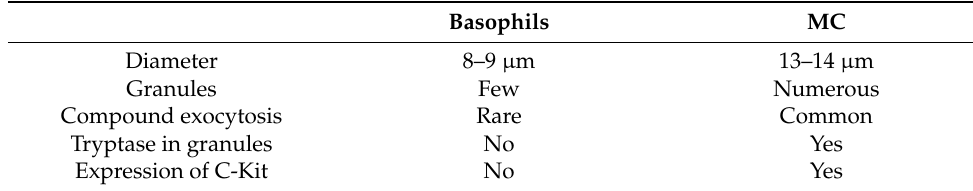
Table 2. Differential features of basophils and MC in